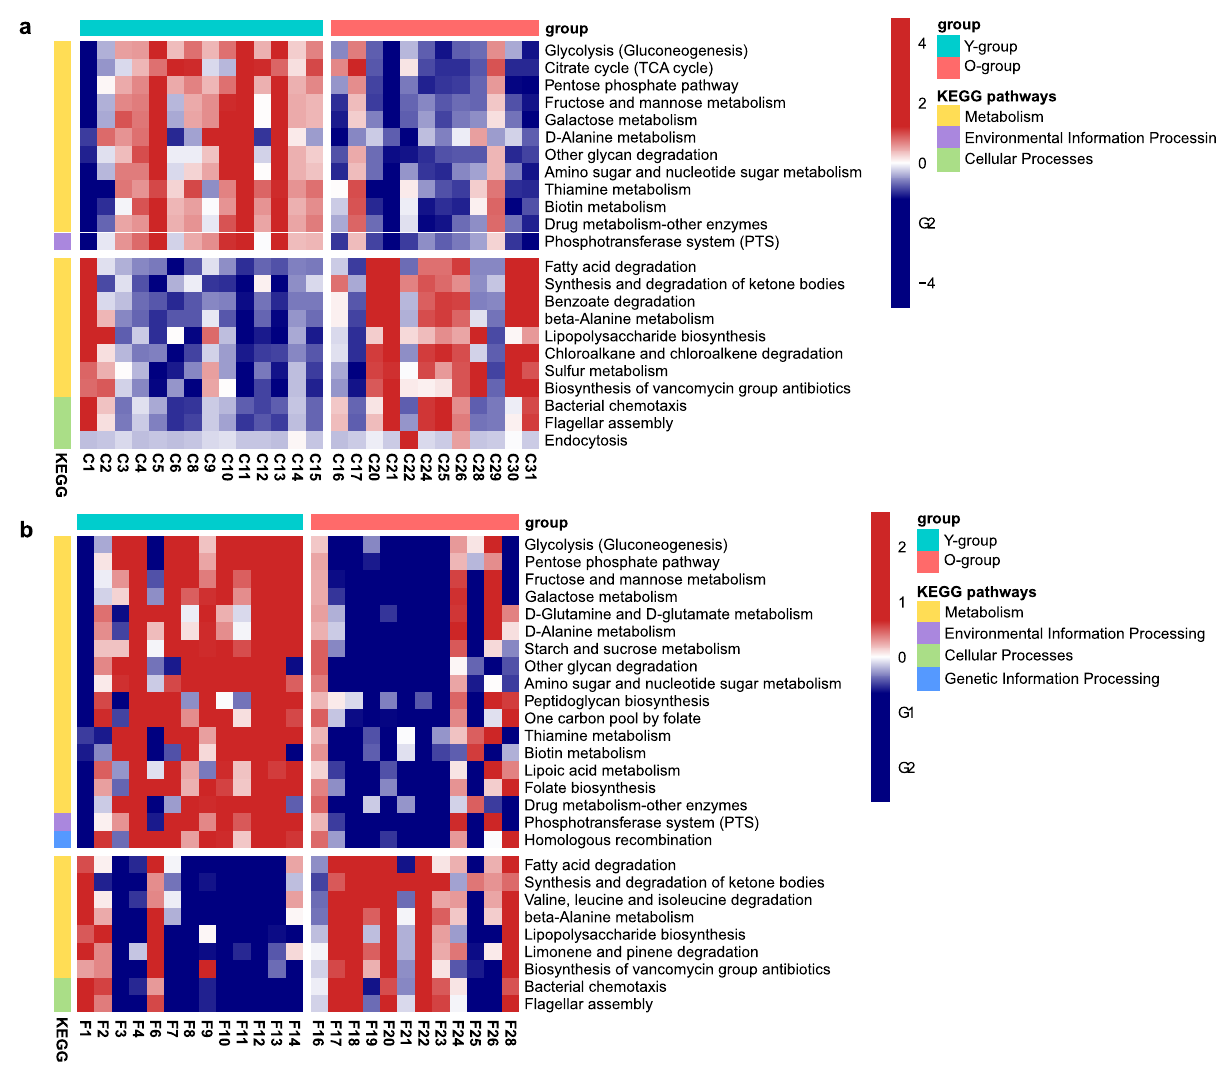
Figure 4. Heat map for significantly different predicted functional pathways on ( a ) cheeks and ( b ) foreheads of Korean women by age based on LEfSe analysis (LDA score >